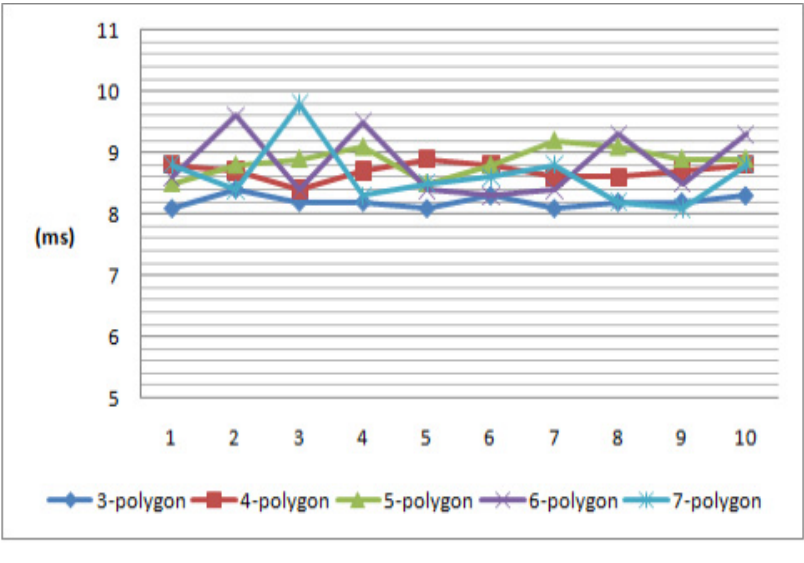
Figure 9. The necessary time to calculate a polygonal shape’s center of